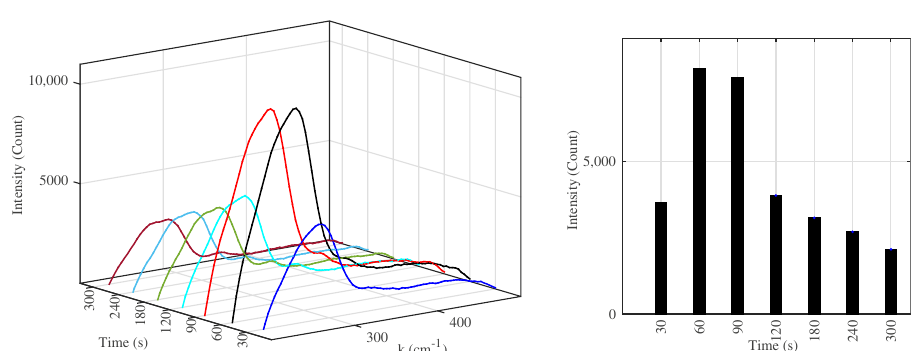
Figure 8. The recorded Raman spectrums from the anode surface at different electrolysis times which show a peak at 290 cm − 1 . The electrolyte was just the ultra-pure water, and the peak intensity changes in a similar pattern as a function of electrolysis time as the Raman measurements done with RhB. This measurement confirms that the nanoparticles are indeed CuO